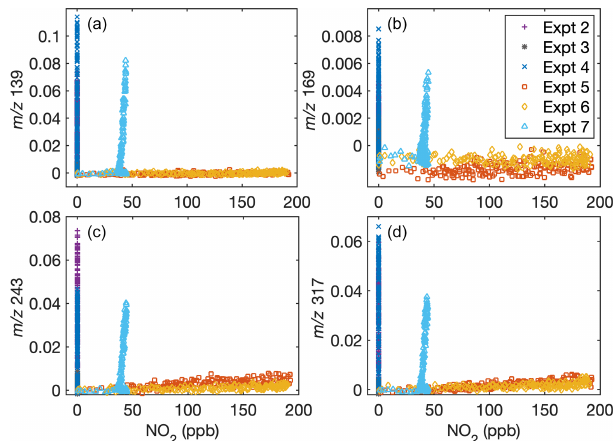
Figure A3. Dependence of gas-phase D5 oxidation products on the NO 2 concentration in the chamber indicates that oxidation chemistry does not depend on NO 2 (but does depend on NO; see Fig. A1). Signals normalized to the reagent concentrations with (a) m/z = 139, (b) m/z = 169, (c) m/z = 243, and (d) m/z = 317 are shown as a function of NO 2 concentration. Because of the inac- curacy of NO 2 measurements during oxidation when methyl nitrite is present, C8 is not